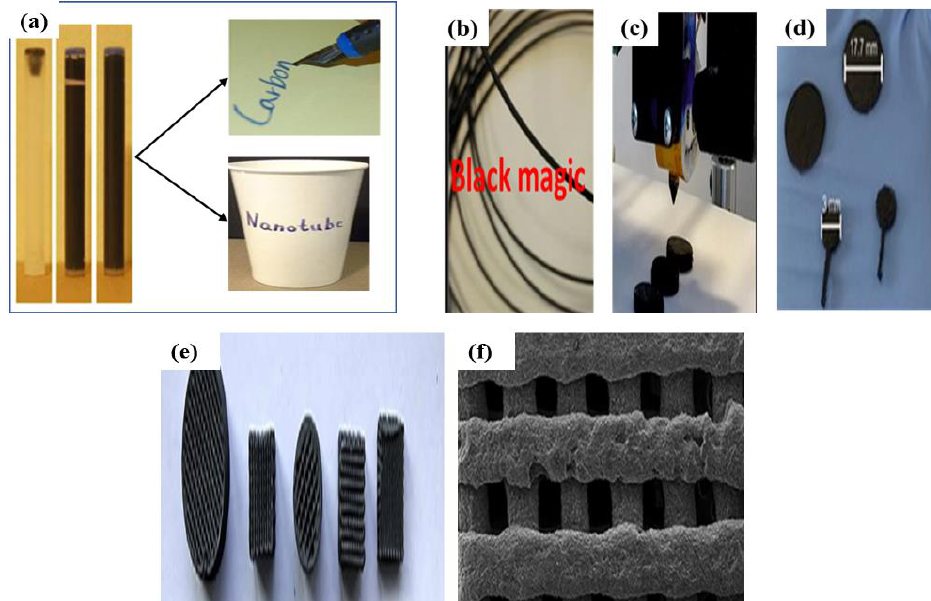
Figure 3. ( a ) Water-based carbon nanotubes ink dispersion in cartridges after 7 days, and